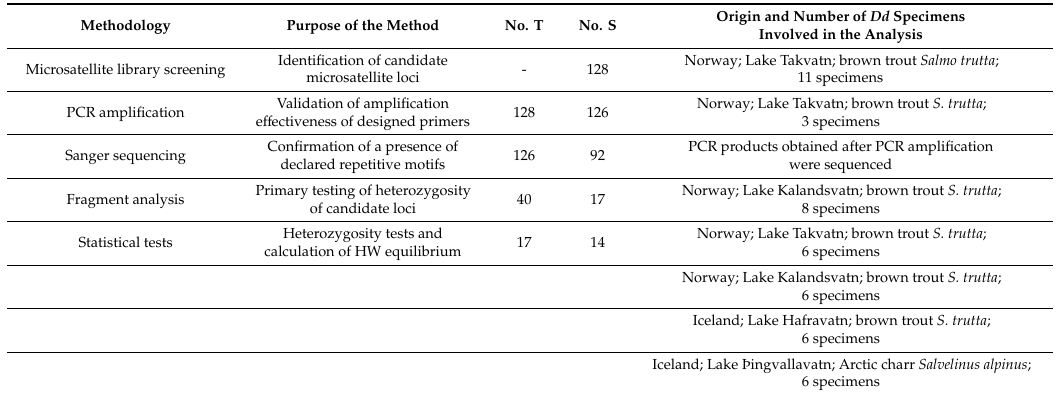
Table 1. Details on di ff erent validation steps applied in development of microsatellite markers in Dibothriocephalus